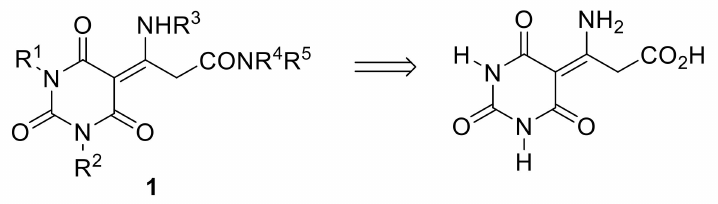
Figure 1. Derivatives 1 of 3-amino-3-(2,4,6-trioxotetrahydropyrimidin-5(2 H )-ylidene)propanoic